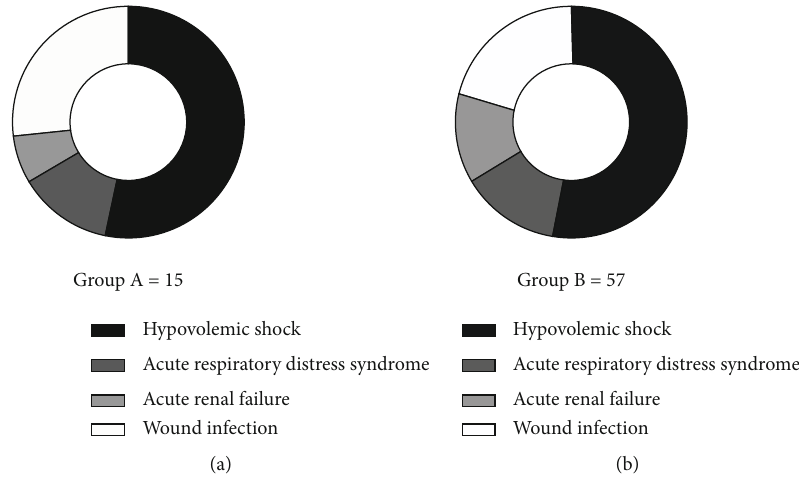
Figure 2: Incidence of patient problems in comparison. Image 2 black region represented hypovolemic shock, the dark-gray region represented acute respiratory distress syndrome, the light-gray area represented acute renal failure, and the white area represented wound infection. (a) Group A; (b) group